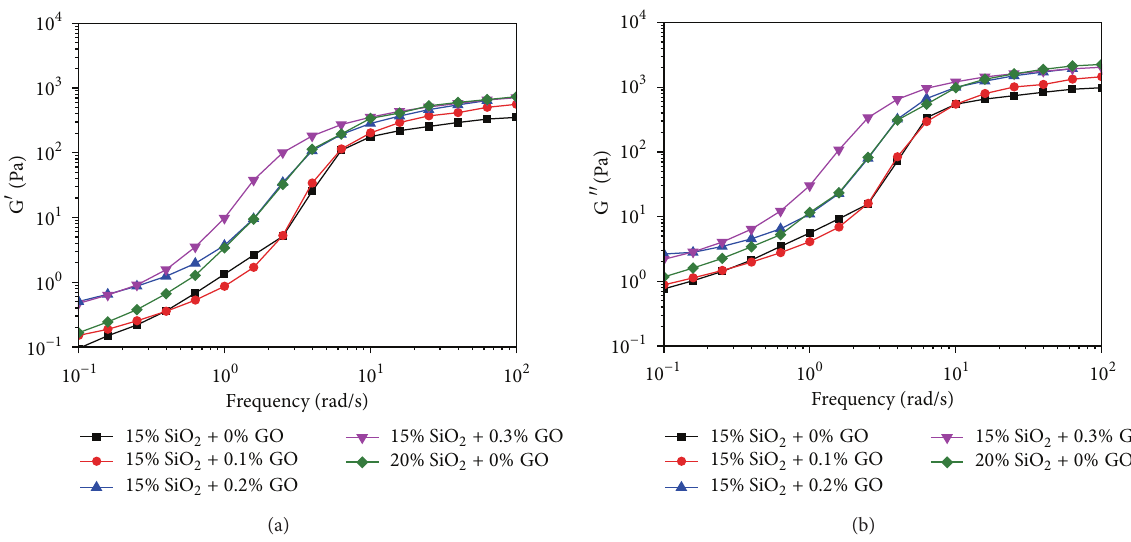
Figure 2: Dynamic frequency test at the constant strain of 250% showing the storage and loss modulus change as a function of frequency sweep for colloidal suspension of fumed silica in PEG with various loading amount of GO and silica (the numbers represent the concentration of each component in weight ratio). (a) Storage modulus as a function of frequency; (b) loss modulus as a function of